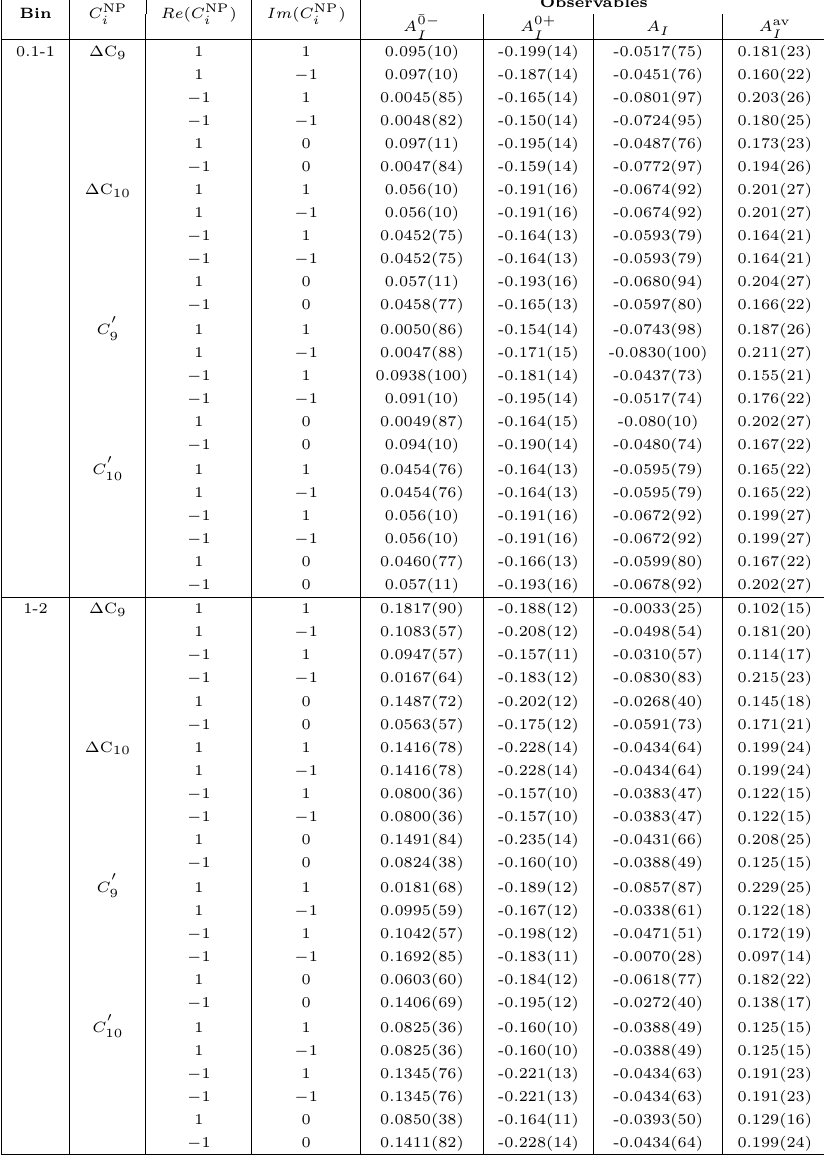
Table 46 . The dependence of the isospin observables corresponding to B → ρll on the real and imaginary parts of the NP WC’s ∆ C and C 0 for the q 2 bins 0 . 1 − 1 and 1 − 2 GeV 2 for a few 9 , 10 9 , 10 benchmark values of the real and imaginary parts of the corresponding